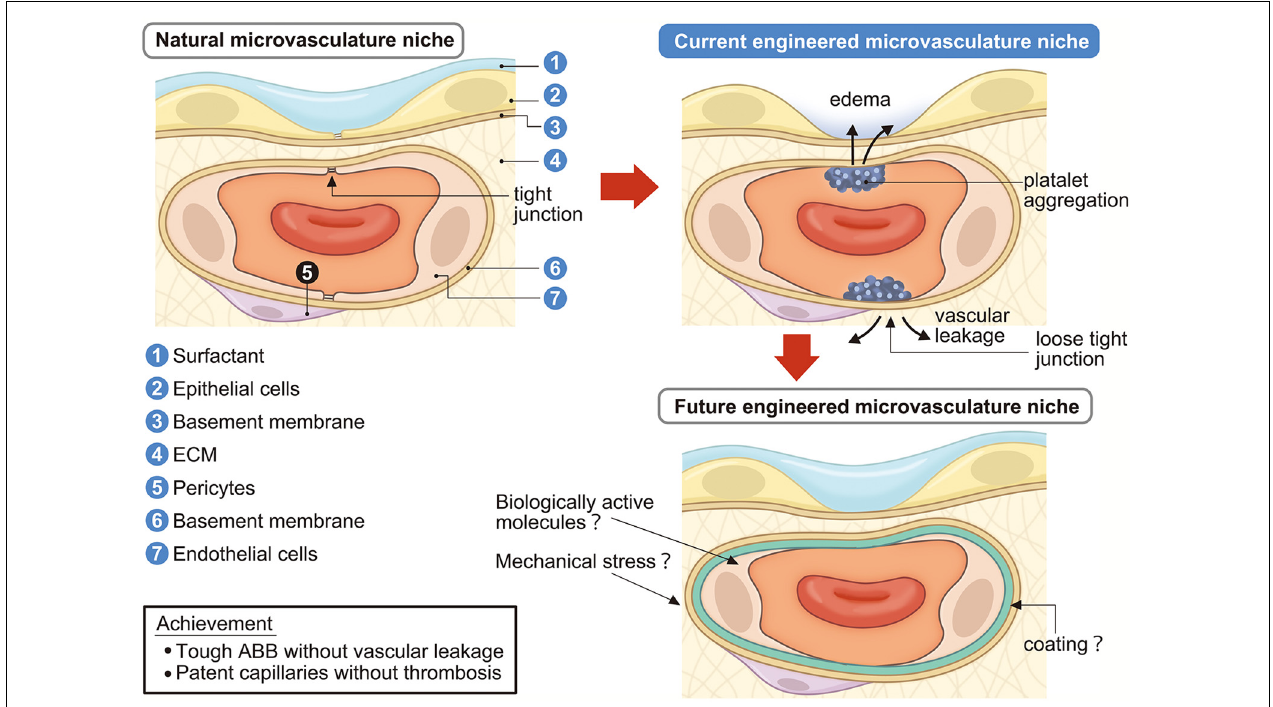
FIGURE 3 | Engineering of lung microvascular niche in the decellularized scaffold. Current engineered microvascular niches consist of incomplete epithelialization and endothelialization which causes vascular leakage, edema, platelet aggregation, and coagulation. Future engineered microvascular niches will achieve a strong ABB without vascular leakage and passable capillaries without coagulation by administrating surfactant, biologically active molecules, mechanical stresses, and/or suitable coating. ECM, extracellular matrix; ABB, alveolar-blood